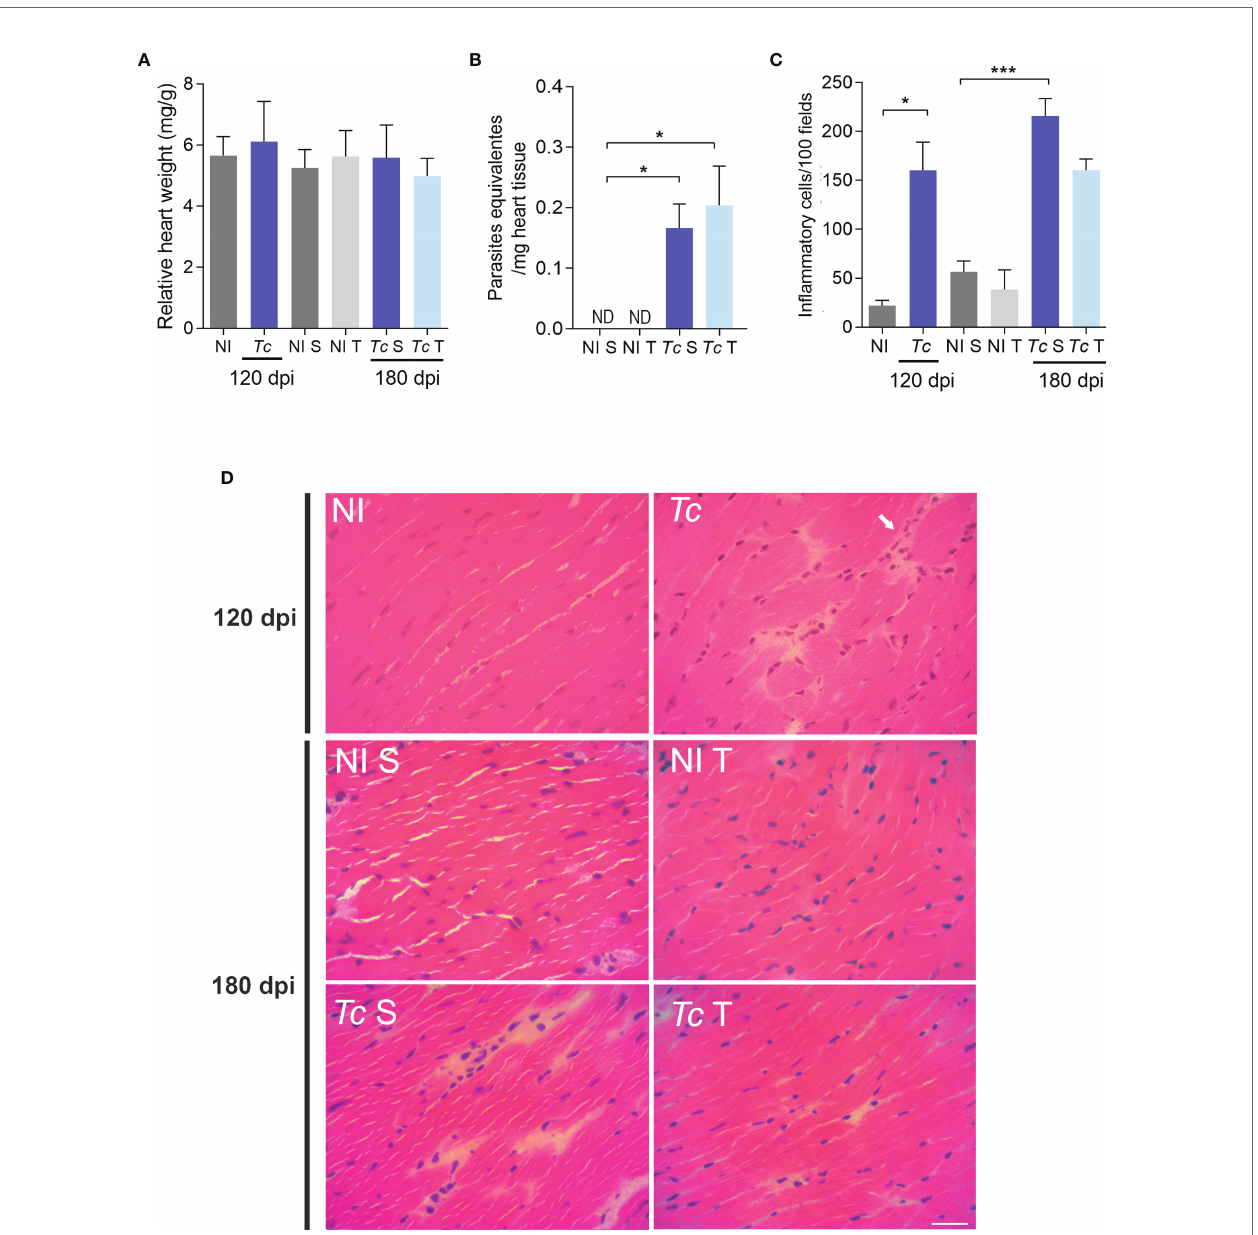
FIGURE 4 | Parasite persistence and in fl ammation in heart tissue of trained Y-infected mice. (A) Relative heart weight. (B) Parasite load at 180 dpi. (C) Quantitative analysis of in fl ammatory in fi ltrates. (D) Representative sections stained with H&E (ND = not detected). The data are represented as means ± SEM. Data represent nine mice per group. Signi fi cant differences between infected and uninfected groups. *p < 0.05; ***p < 0,001. ( Mann – Whitney; Kruskal – Wallis test , Dunn ’ s posttest